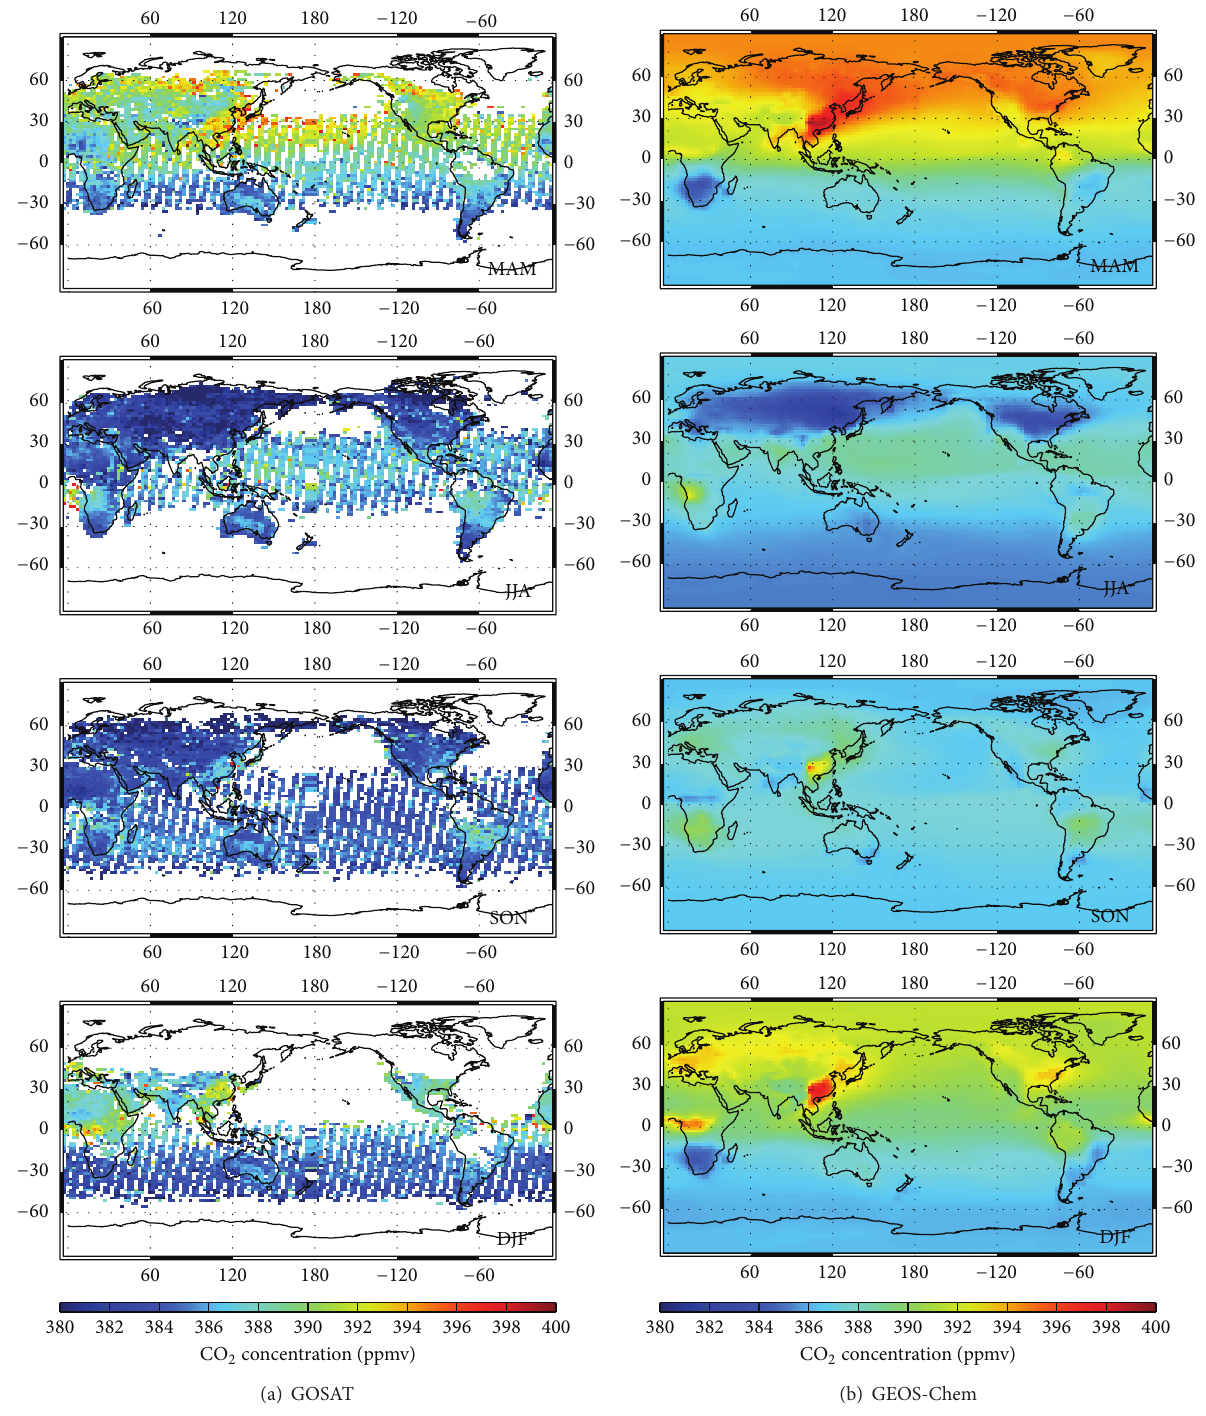
Figure 3: Seasonal variation and global distribution of the column-averaged CO 2 concentration (a) measured by GOSAT SWIR and (b) simulated by GEOS-Chem. MAM denotes the period from March to May, JJA from June to August, SON from September to November, and DJF from December to